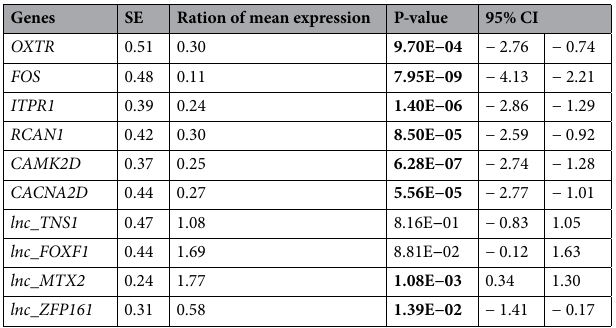
Table 2. Detailed parameters of expression analysis of oxytocin-related genes in breast cancer samples compared with nearby non-cancerous